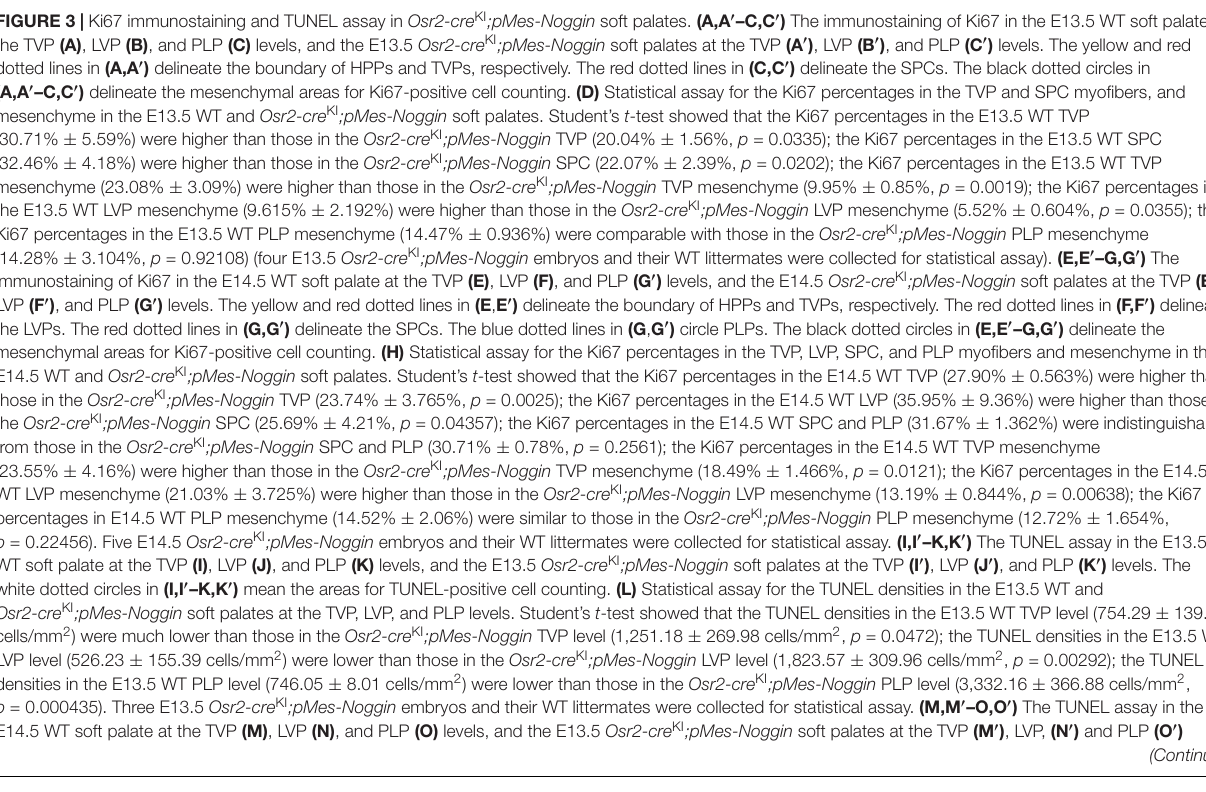
Frontiers in Cell and Developmental Biology |